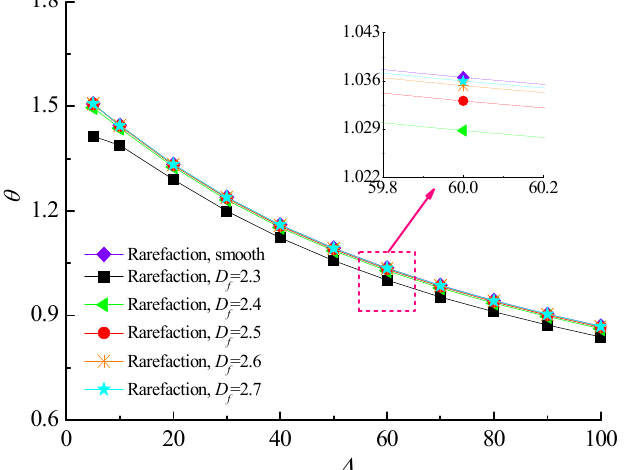
Figure 10. Attitude angles versus bearing number for different fractal dimensions at ε = 0.6, G = 1 × 10 −10 .